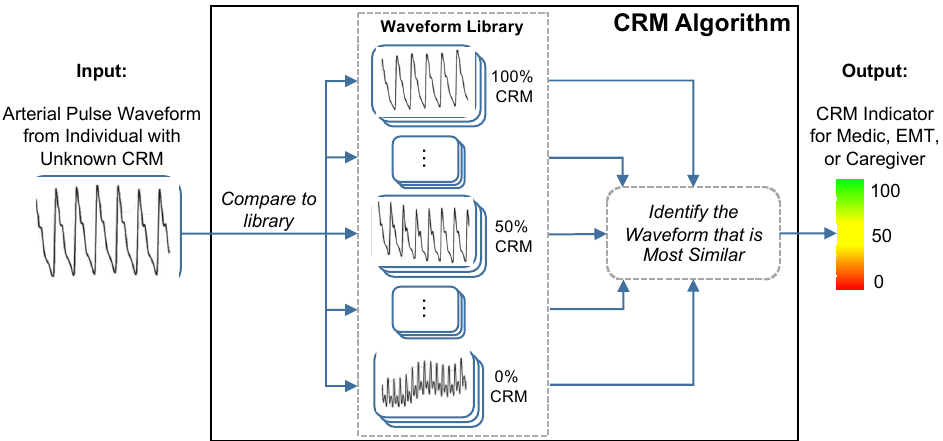
Figure 5. The conceptual framework of the compensatory reserve measure (CRM) algorithm. The input waveform from the current subject is compared to a library of more than 650,000 waveforms recordings collected from more than 260 subjects exposed to experimentally-controlled progressive reductions in central blood volume by lower-body negative pressure to generate an estimated individual compensatory reserve measurement (CRM). Image modified from [50].